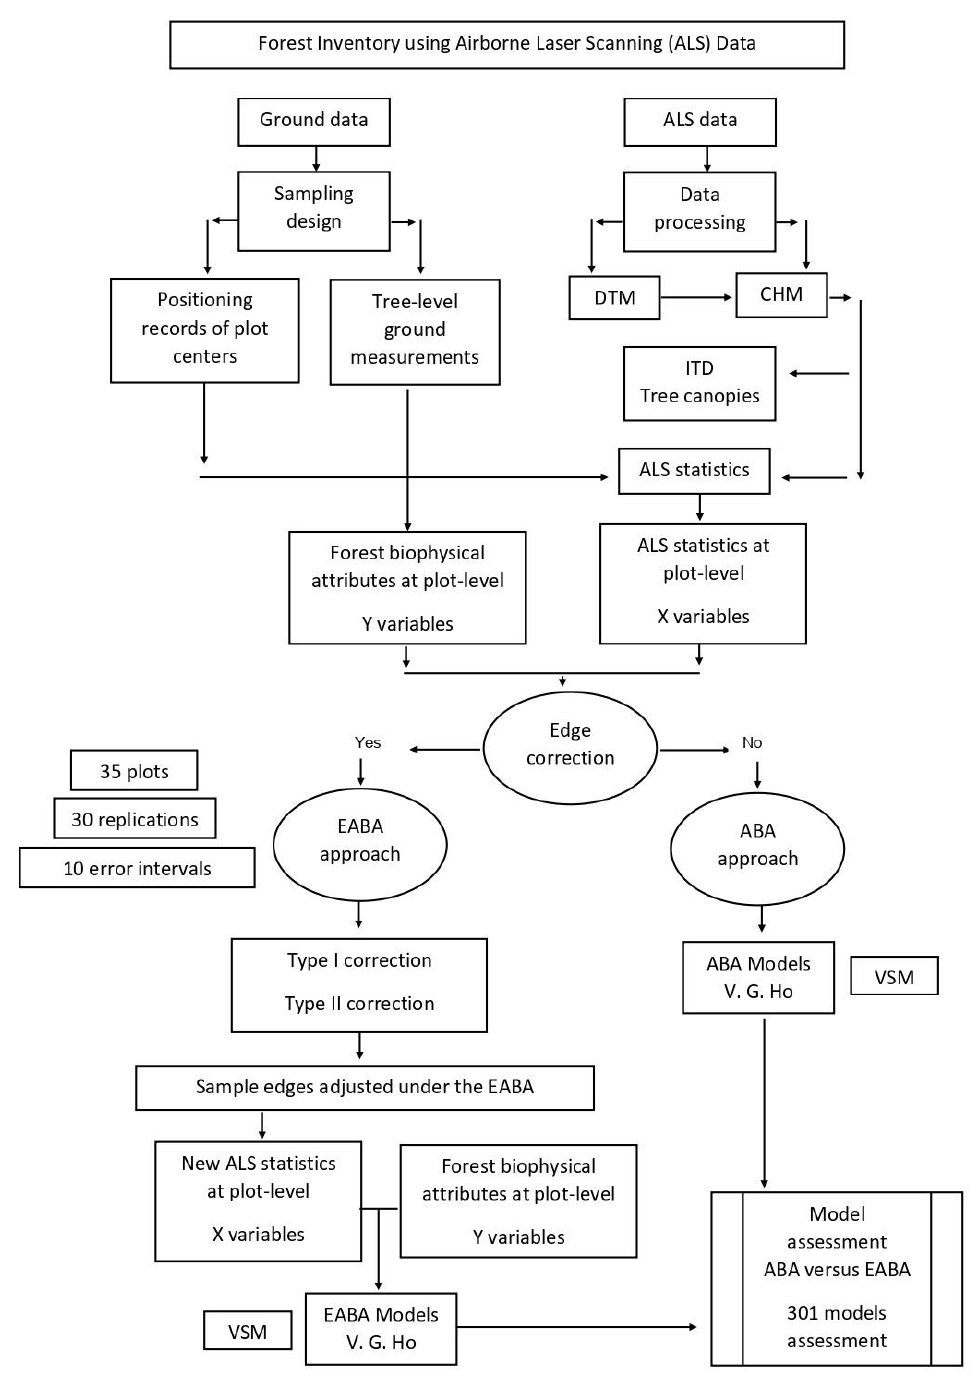
Figure A1. Flowchart presenting all the steps conducted in the research involving forest inventory based on airborne laser scanning, edge correction, and modeling.